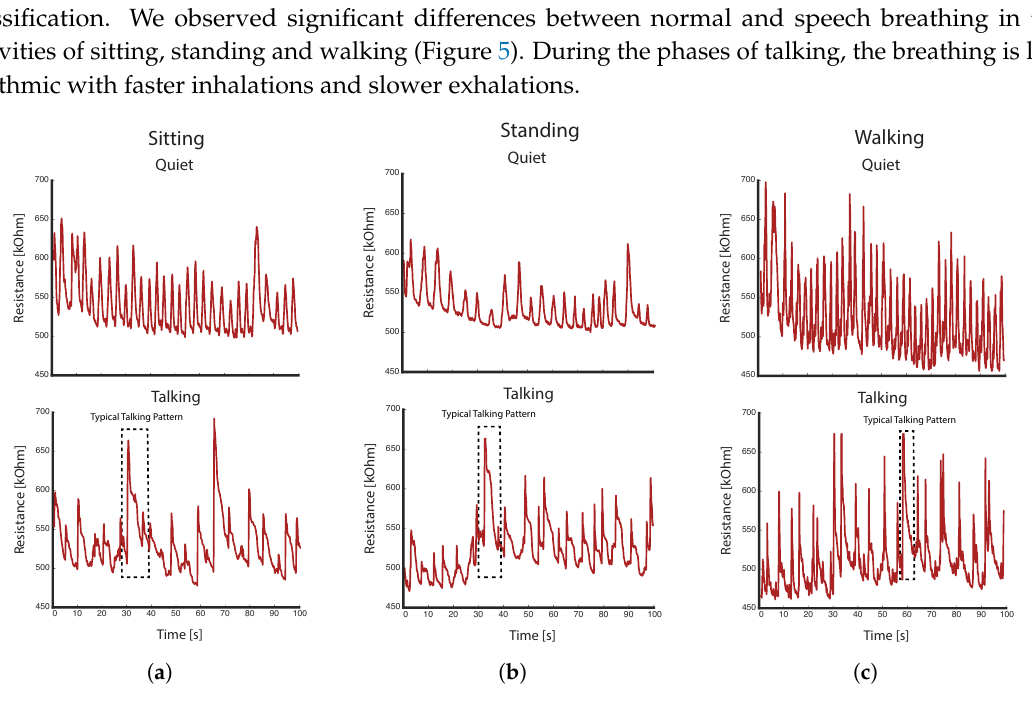
Figure 5. Comparison of the raw sensor signals (upper chest band) between quiet and speech breathing (i.e., talking) for: ( a ) sitting; ( b ) standing; and ( c )